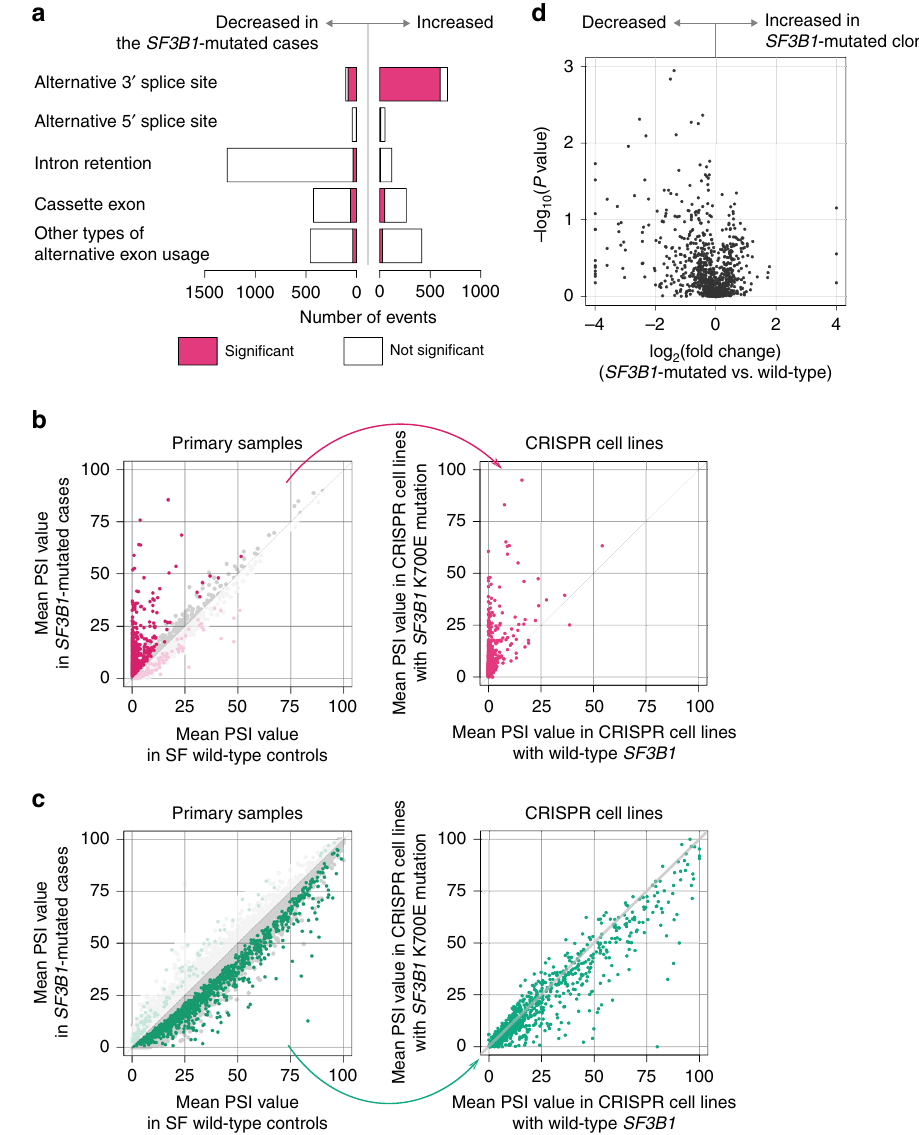
Fig. 5 Recapitulation of mutant SF3B1 -associated abnormal splicing in vitro. a The number of mutant SF3B1 -associated events that showed a consistently signi fi cant difference in CRISPR cell lines with the SF3B1 K700E mutation. Bars on the right indicate alternative splicing events that were more frequently found in SF3B1 -mutated cell lines. Bars on the left represent those that were more frequently found in the controls. Red bars indicate events with consistent changes with a P value <0.05 in CRISPR cell lines. b , c Scatter plots showing mean PSI values of mutant SF3B1 -associated alternative 3 ′ splice sites ( b ) and intron retention ( c ). The left and right panels show mean PSI values in primary bone marrow samples and in CRISPR cell lines, respectively. d A volcano plot comparing mean PSI values of mutant SF3B1 -associated intron retentions between CRISPR cell lines with and without the SF3B1 K700E mutation ( n = 3 each). X -axis indicates fold changes in PSI values on a log Y -axis indicates P values on a negative log 2 scale. 10